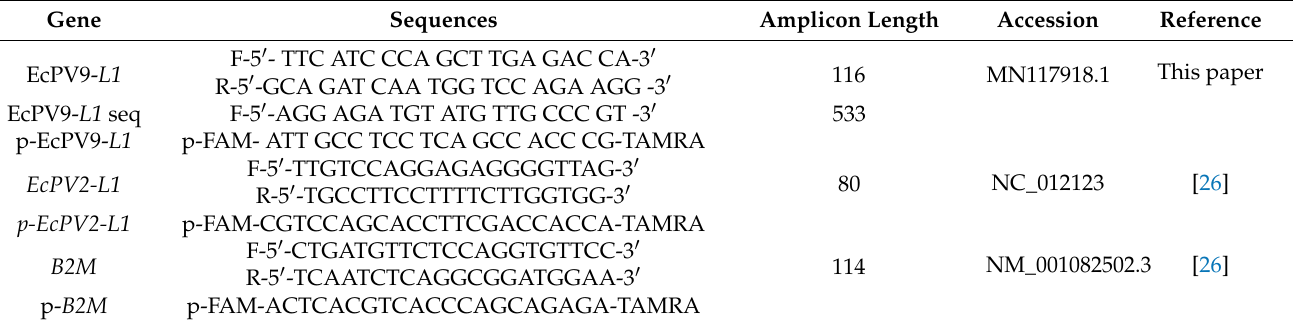
Table 1. Primers set and probes for EcPV9- L1 detection and sequencing and for EcPV2- L1 detection.